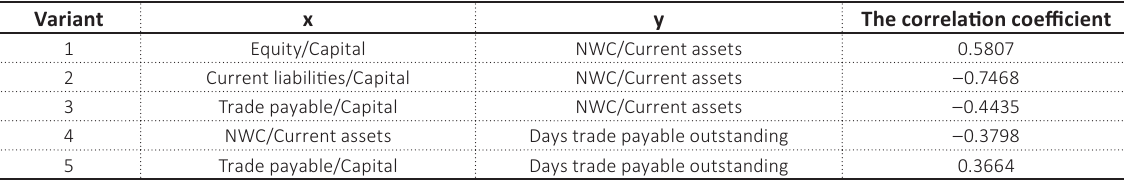
Source: Calculated by the author.